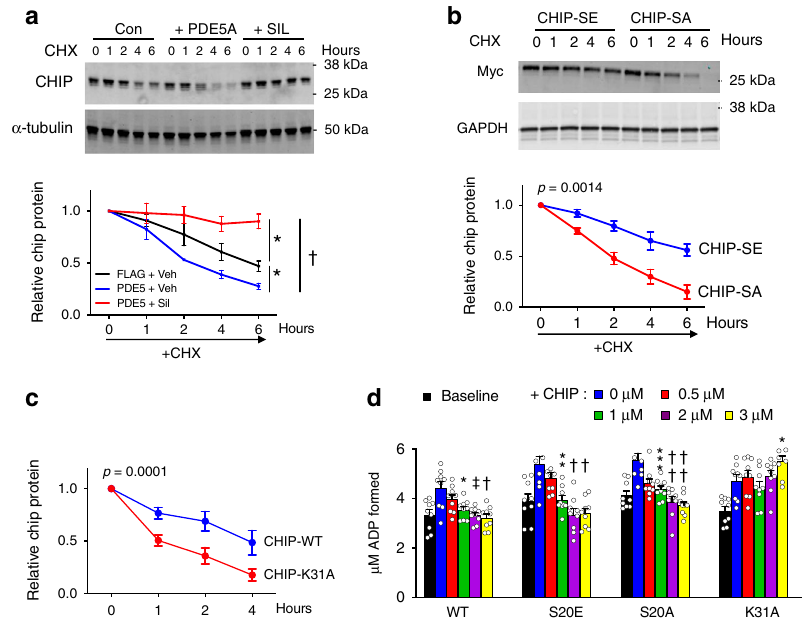
Fig. 7 In fl uence of S20 modi fi cation on CHIP post-translational half-life. a NRCMs infected with AdV-Flag or AdV-Flag-PDE5 to reduce PKG activation, and with SIL added to enhance PKG activation placed in media containing cycloheximide (CHX, 100 µ M) to block protein synthesis and H 2 O 2 (50 µ M) to induce oxidative stress. N = 4 – 5 separate experiments with 5 independent time points per experiment. ANCOVA results for differences between paired relations: * p = 0.001; † 0.000009. b Same general protocol but with NRCMs over-expressing either S20A or S20E CHIP mutants. P -value for slope difference by ANCOVA. c Same protocol but WT and K31A CHIP mutants. P -value for offset difference by ANCOVA. d Hsp70/Hsp40 dependent protein refolding ATPase assay showing capacity of CHIP to reduce activity in a dose dependent manner in wild type (WT), S20A, and S20E CHIP mutants. K31A CHIP expression prevents this negative modulation. N = 9 biological replicants, RMANOVA performed within each experiment, Dunnets mct: * p = 0.004; **0.006, ***0.002; † 0.0005, †† 0.0002, ‡ p = 0.002 – each versus no CHIP added (blue bar). Source data are provided as a Source Data fi le. Regressions ( a – c ) and summary plot ( d ) each display mean ±